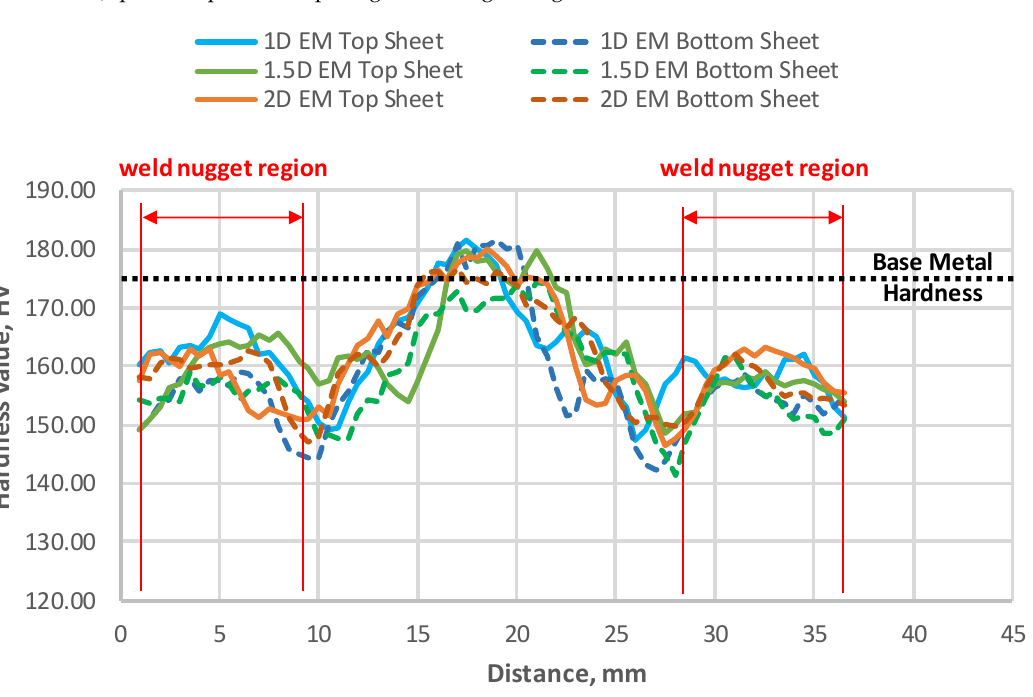
Figure 18. Microhardness values of the 4D-pitch cross-section specimens. Notes: D = 7 mm (Spot Weld Diameter); pitch = Spot Weld Spacing; EM = Edge Margin.